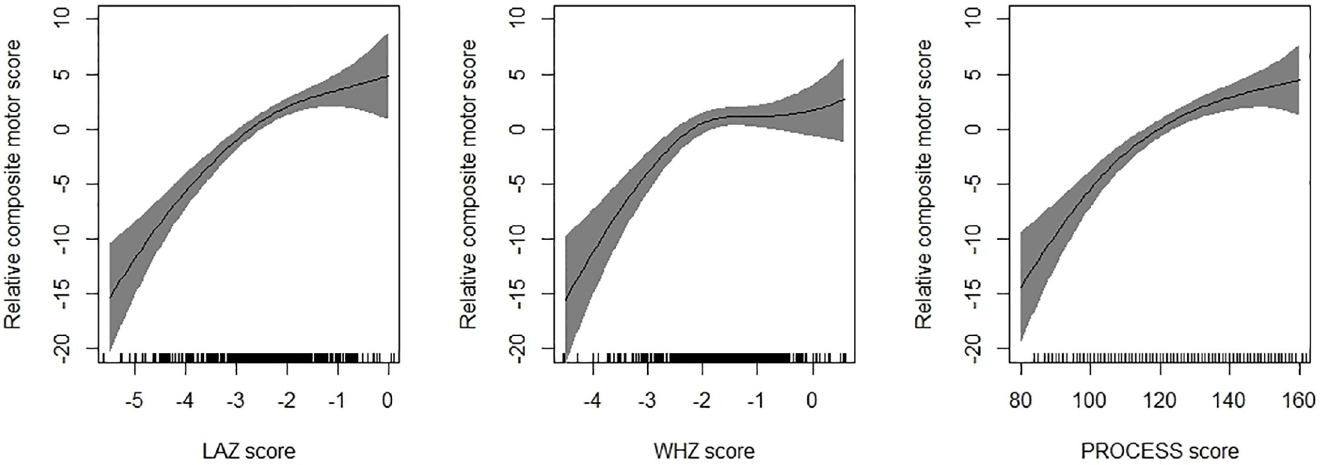
Fig 3. Associations between height for age z-scores (HAZ); weight for height z-scores (WHZ), PROCESS score and change in composite motor score. The graphs were constructed using generalized additive models in R, the solid line depicts the association of composite motor score and HAZ/WHZ/PROCESS score. The Y-axis is centered on the mean composite motor score. The shaded area spans the 95% confidence interval of this association.